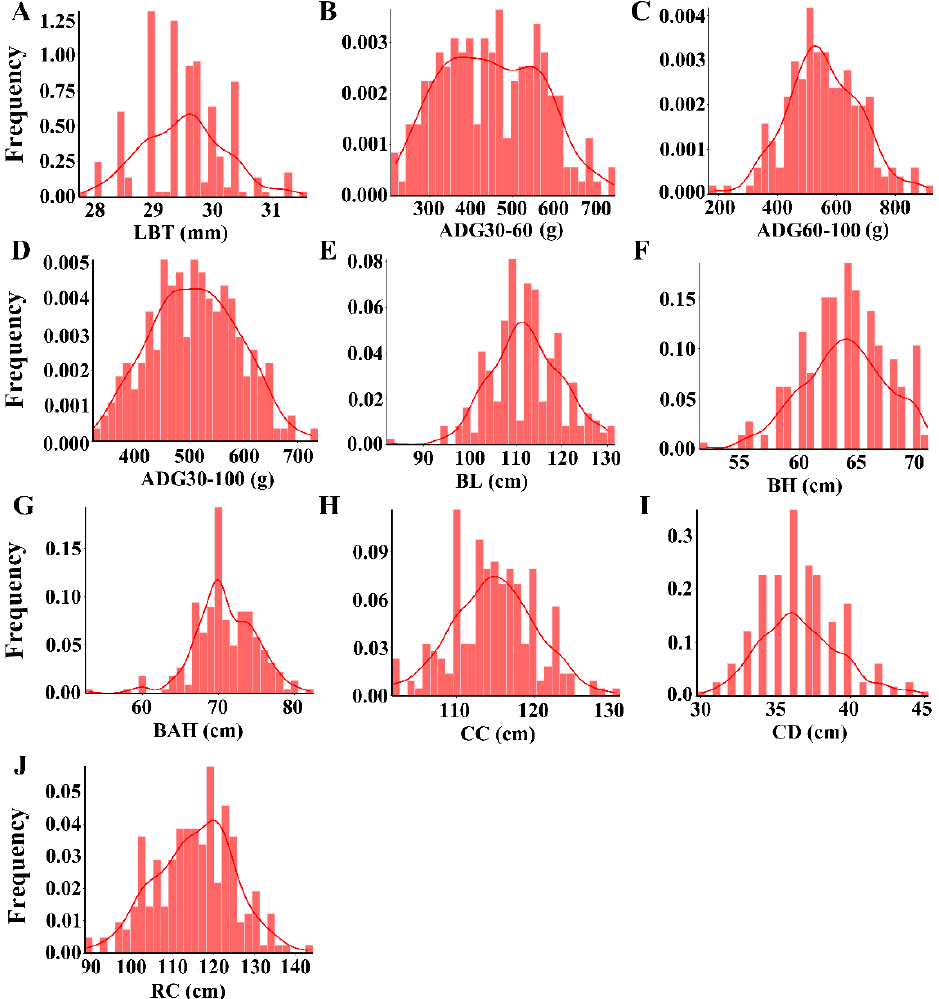
Figure 1. Frequency distribution histogram for ten growth traits. ( A ) Live backfat thickness (LBT), ( B ) Average daily gain from 30 to 60 kg (ADG30–60), ( C ) Average daily gain from 60 to 100 kg (ADG60–100), ( D ) Average daily gain from 30 to 100 kg (ADG30–100), ( E ) Body length (BL), ( F ) Body height (BH), ( G ) Back height (BAH), ( H ) Chest circumference (CC), ( I ) Chest depth (CD), ( J ) Rump circumference (RC). Table 1. Phenotypic correlation coefficients among ten growth traits in crossbred pigs.